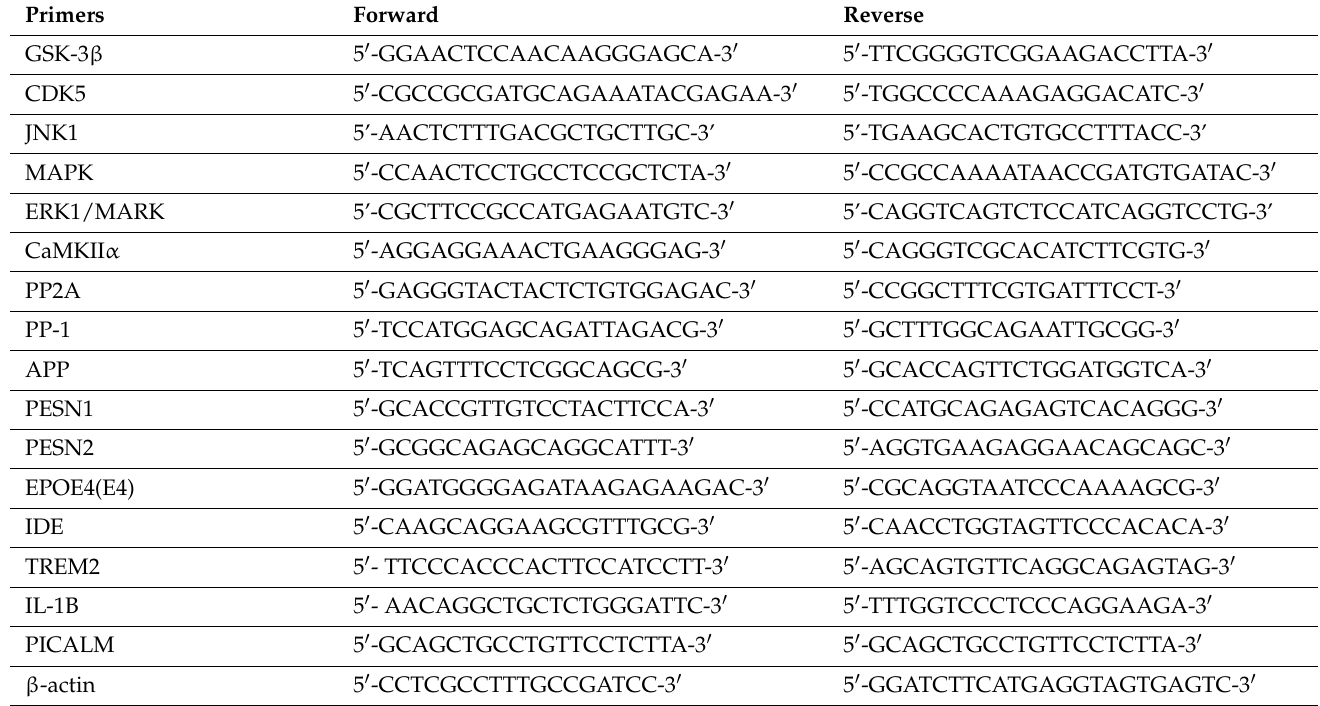
Table 1. Primer sequences used for qRT-PCR analysis of various